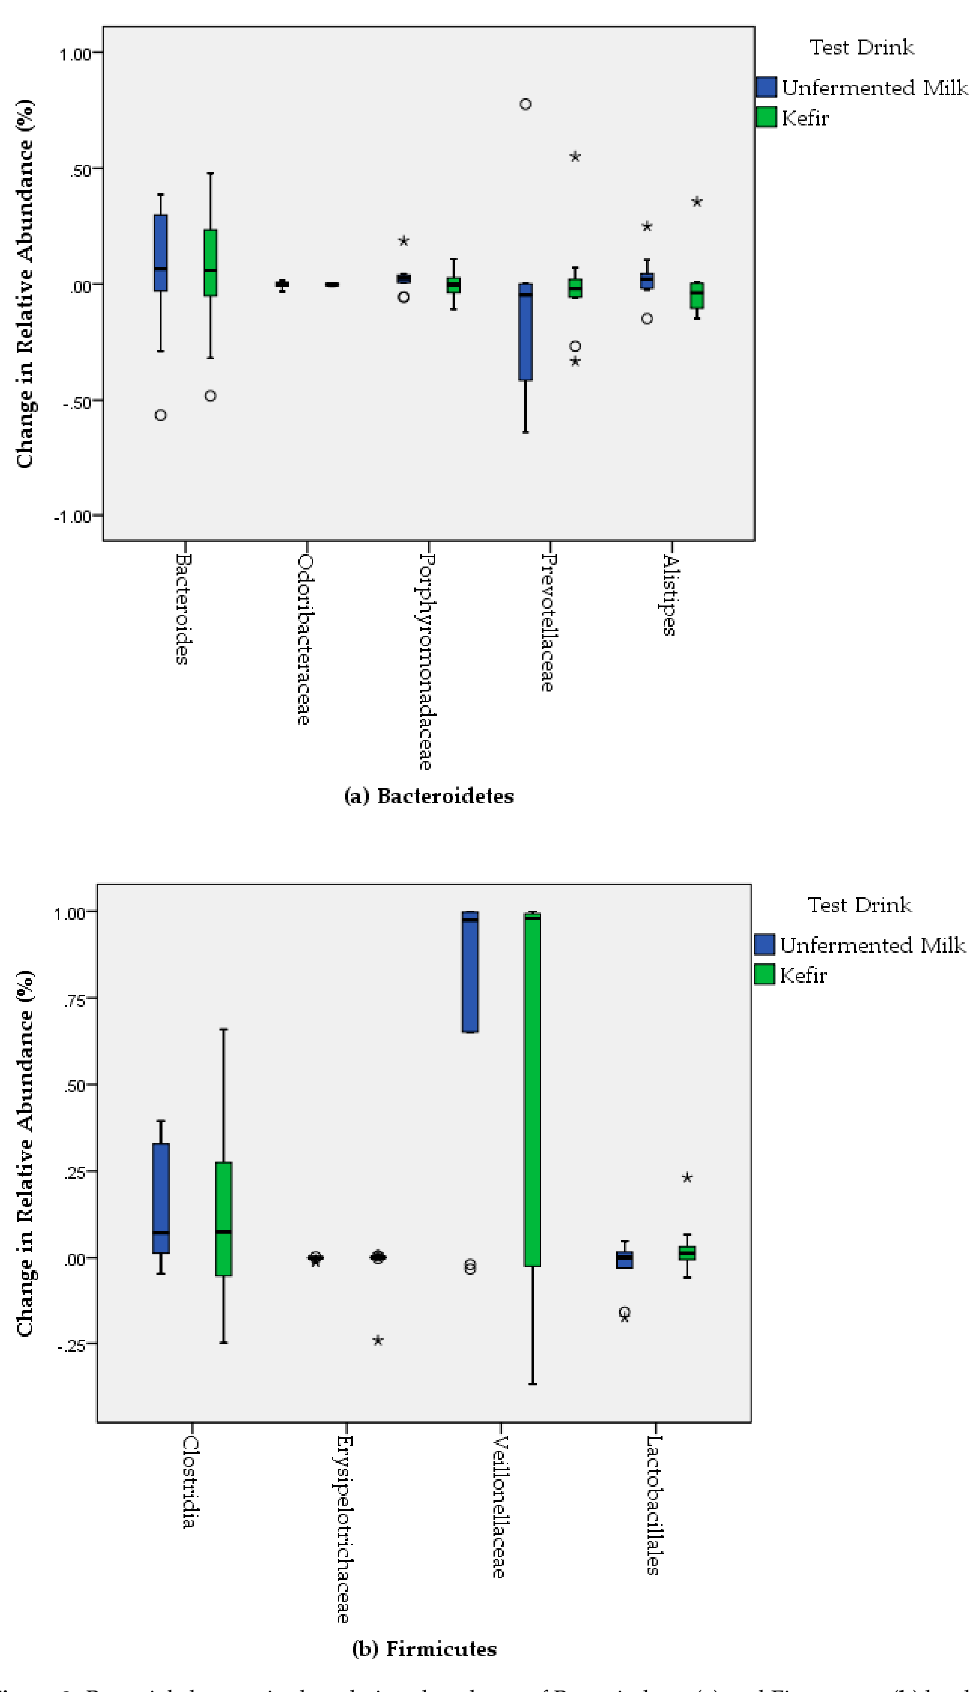
Figure 3. Bacterial changes in the relative abundance of Bacteriodetes ( a ) and Firmucutes ( b ) by the consumption of test drinks.